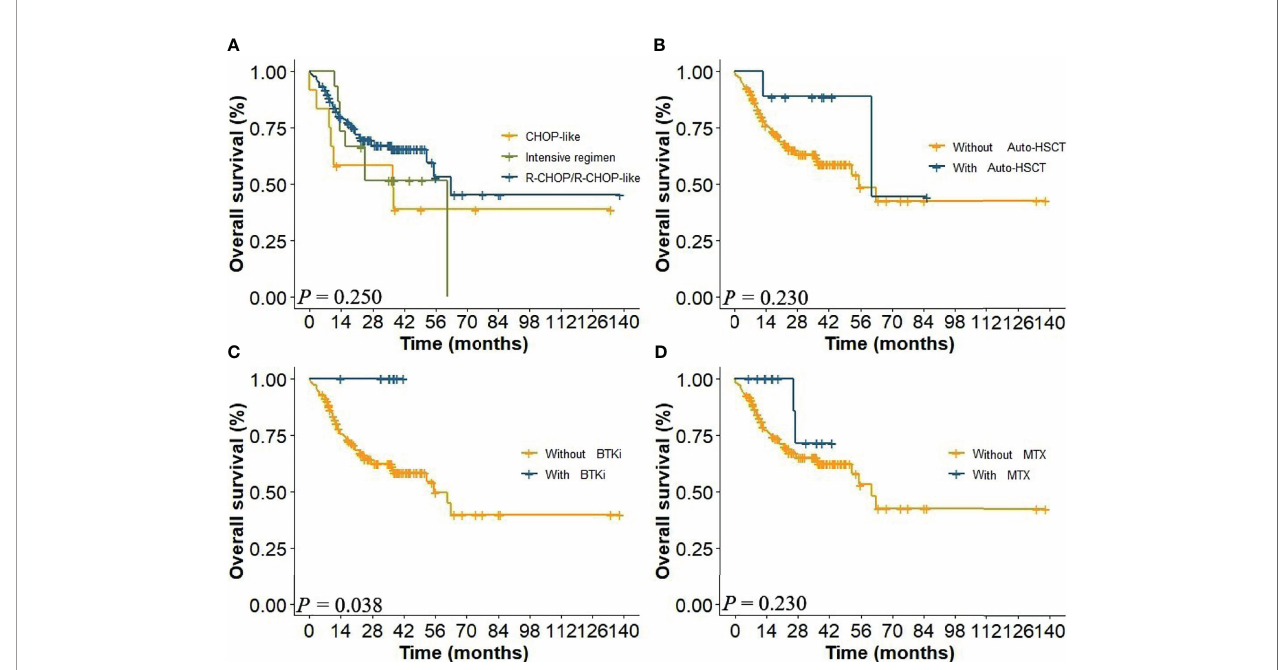
FIGURE 1 | (A) Overall survival (OS) of patients in the whole cohort of different therapeutic regimens and with or without (B) auto-HSCT, (C) BTKi, and (D) MTX.